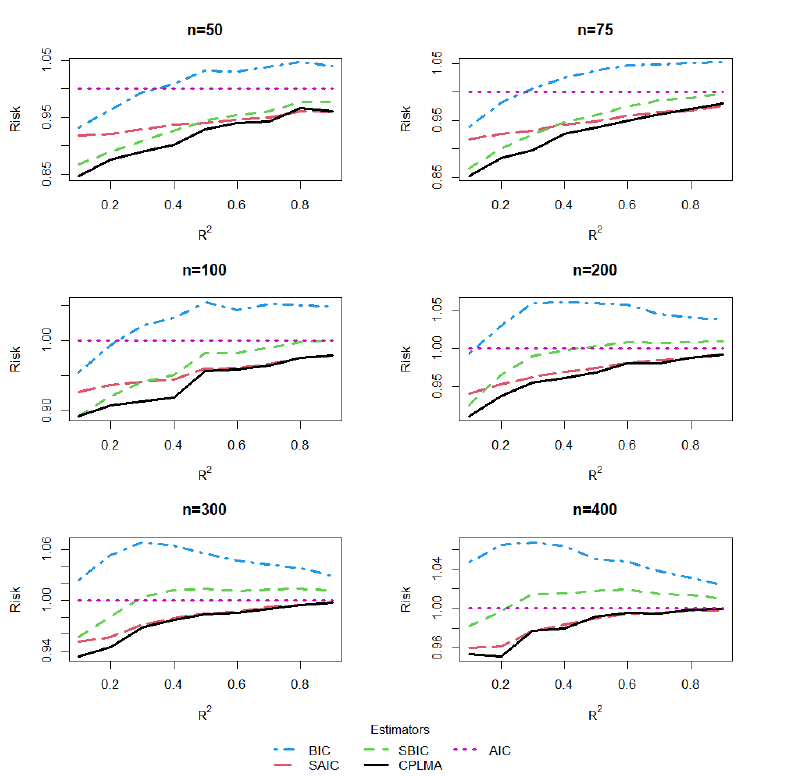
Figure 3. Risk comparisons for Design 1 when α = 0.5 and the censoring rate is about 20%.